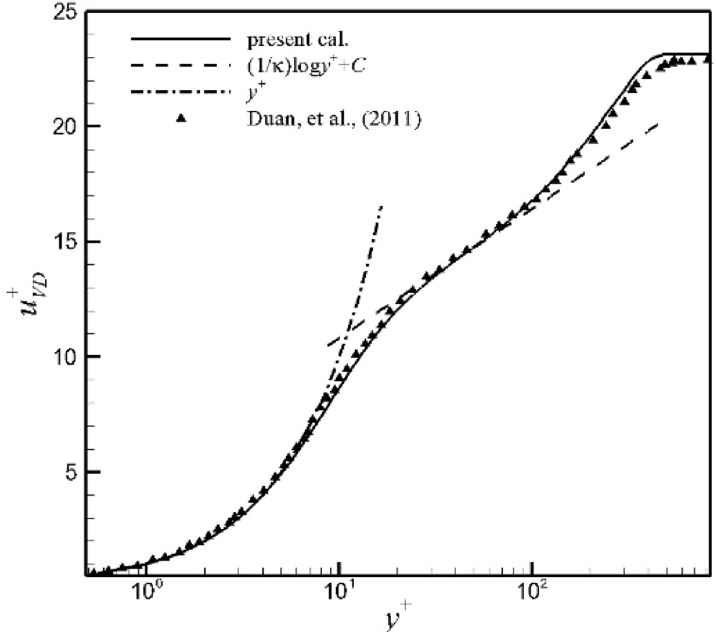
Fig. 4 Profile of van Driest transformed mean velocity obtained at Re θ